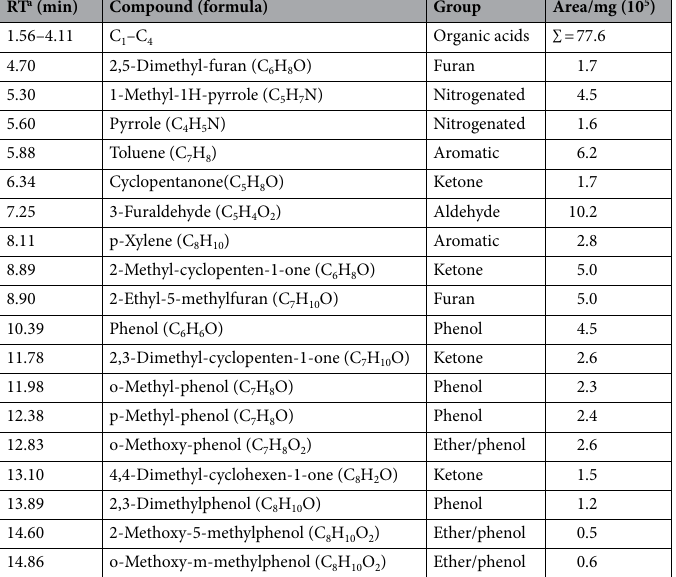
Table 3. Conventional pyrolysis products distribution at 500 °C. a Retention time